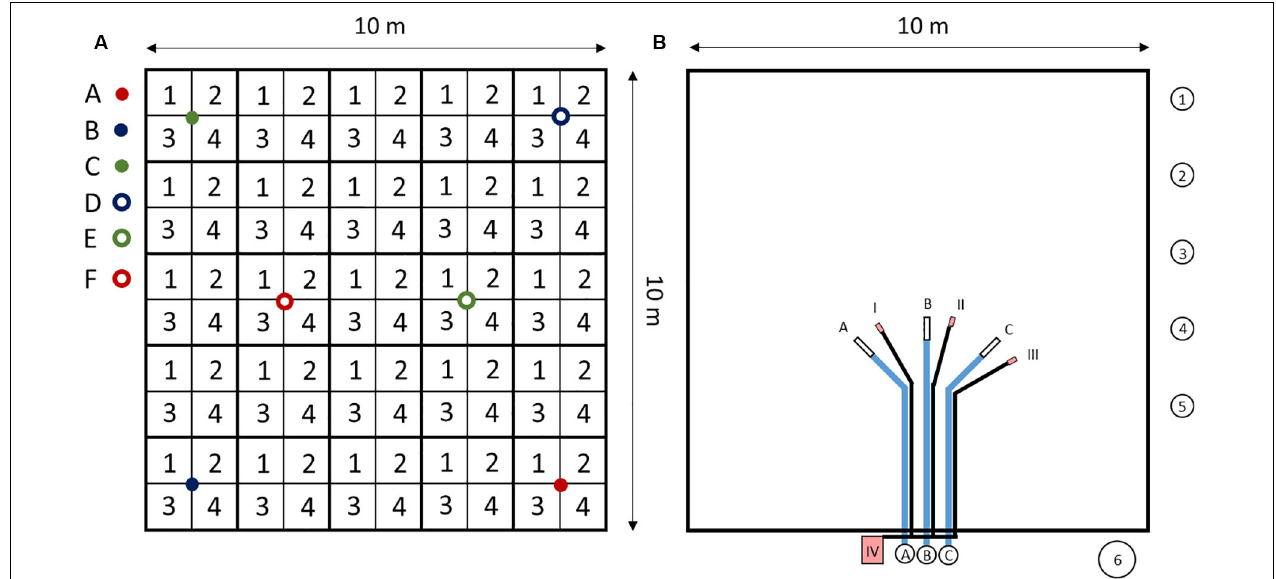
FIGURE 2 | 10 × 10 m plot of the study sites. (A) Soil sampling. 1–4: area mixed samples from 0 to 20 cm depth, each consisting of 25 subsamples. A–F: HUMAX core samples, separated into four depths (0–20 cm, 20–50 cm, 50–75 cm, > 75 cm), used to determine bulk soil density and coarse soil content ( > 2 mm). For further soil analysis, HUMAX core samples were pooled to three samples (A&F, B&D, and C&E). (B) Seepage water sampling, atmospheric deposition sampling and soil water content measurements. A–C: Suction cups with tubes and sampling bottles. 1–5: atmospheric deposition samplers. 6: snow sampler. I-III: EC-5 sensors to measure soil water contents. IV: HOBO R (cid:13) datalogger to record soil water measurement